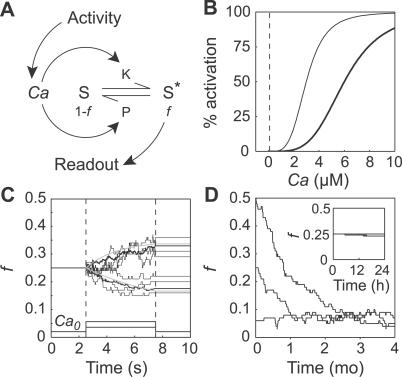
The aKP Cycle Model(A) In its macroscopic determinist approximation, the model consists of a simple reaction scheme. The nonphosphorylated (S) and phosphorylated (S*) forms are present with fractions 1 − f and f, respectively, and are interconverted with rates K and P by the kinase and a phosphatase. Enzymes are activity dependent through calcium, and f is the readout variable.(B) Kinase (thick line) and phosphatase (thin line) calcium activation functions. Dashed line indicates Ca
0, the basal Ca (0.1 μM).(C) Rapid plastic modifications in f in response to Ca pulses from Ca
0 to 6 μM (upper traces) and 3 μM (lower traces) in the stochastic (individual traces: thin black trace; mean trace [n = 20]: thick black trace) and deterministic (thick gray trace) models.(D) Relaxation of f at Ca
0 from different f values. Inset: enlargement of three relaxation traces during 24 h illustrates the low evolution rate of f.